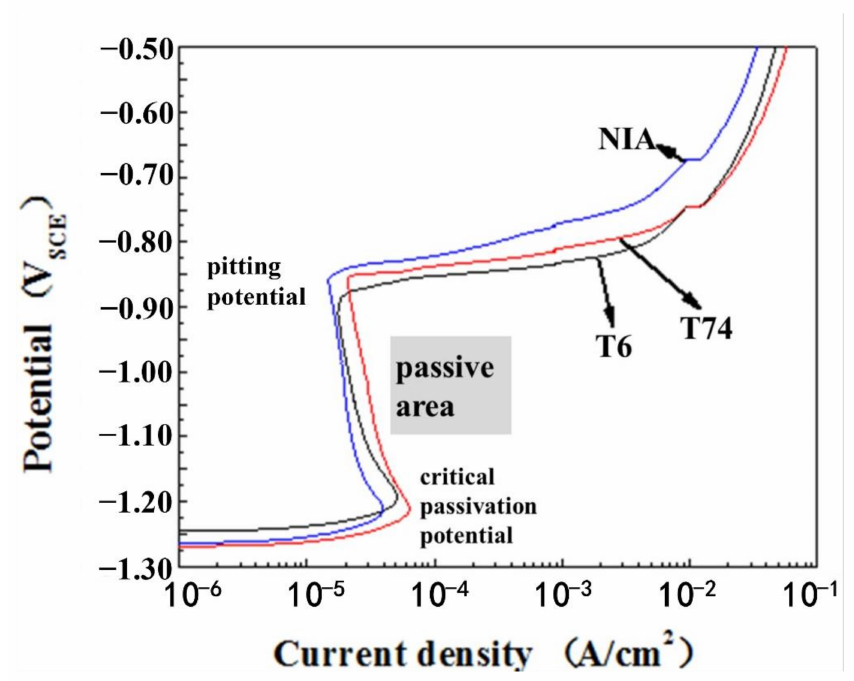
Figure 3. The polarization curves of the7N01 extrusion aluminum alloy after different aging. The correlation data of polarization curves are obtained by Tafel (cid:48) s extrapolation. The